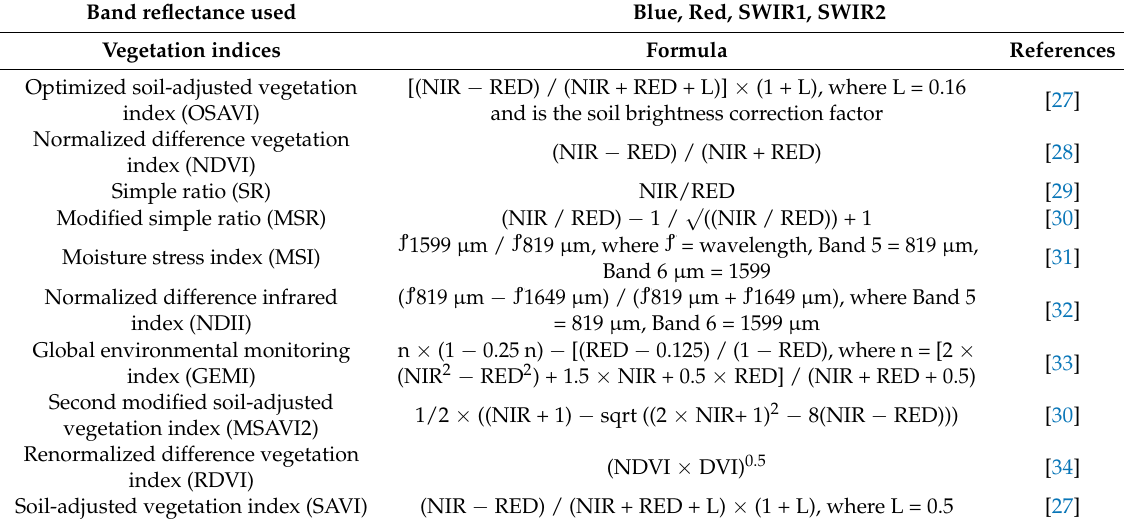
Table 2. Important image spectral information and vegetation indices selected for the RF model. Band reflectance